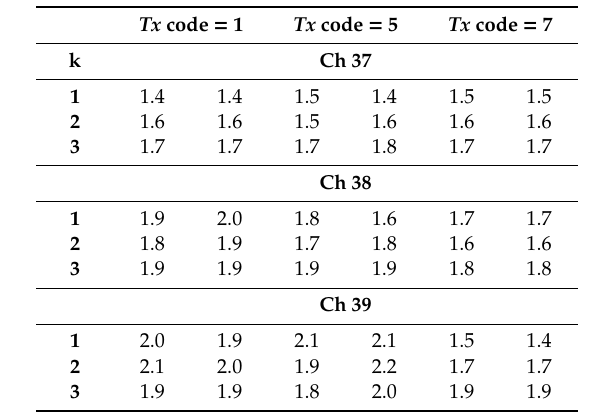
Table 6. Accuracy (in m) for Tests #1. For each Tx code, the first and second data columns refer to the iBeacon and Eddystone protocol respectively. The three advertising channels are referred to as Ch 37, etc., and the number of neighbors in the WKNN algorithm, as k .